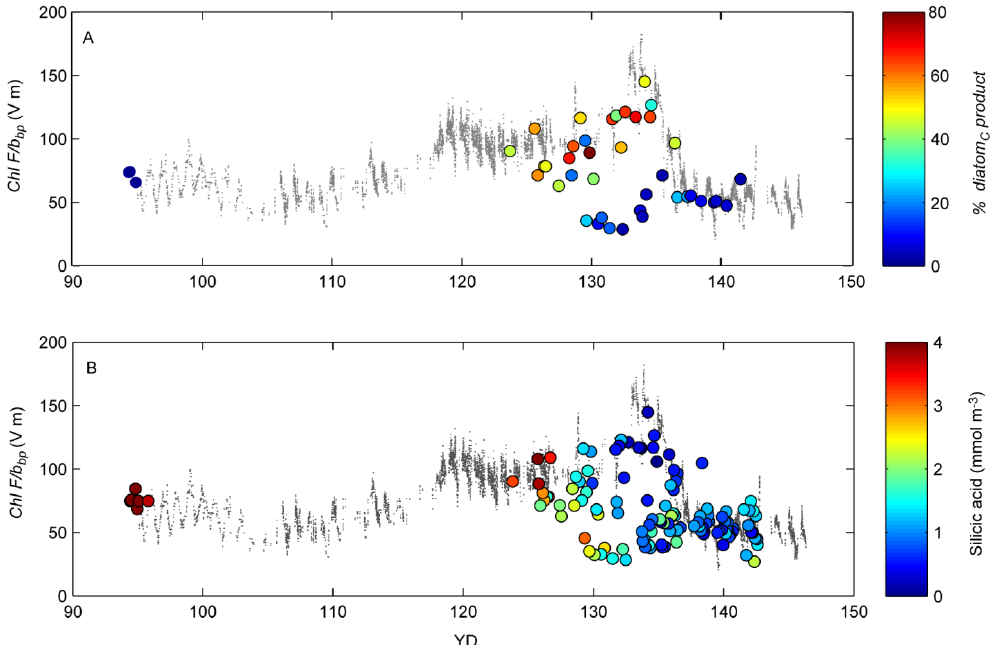
Figure 6. Optical community index, Chl F/b bp , from ship CTD profiles (circles) superimposed on float data (gray); 10–50m median is plotted for each ship profile. (a) The optical community index color-coded by % diatom C product ( n = 42). The index was high when the relative diatom abundance was high. (b) Same as a but color-coded according to Si concentration. Highest values of Chl F/b bp were concurrent with lowest values of Si ( n = 123).